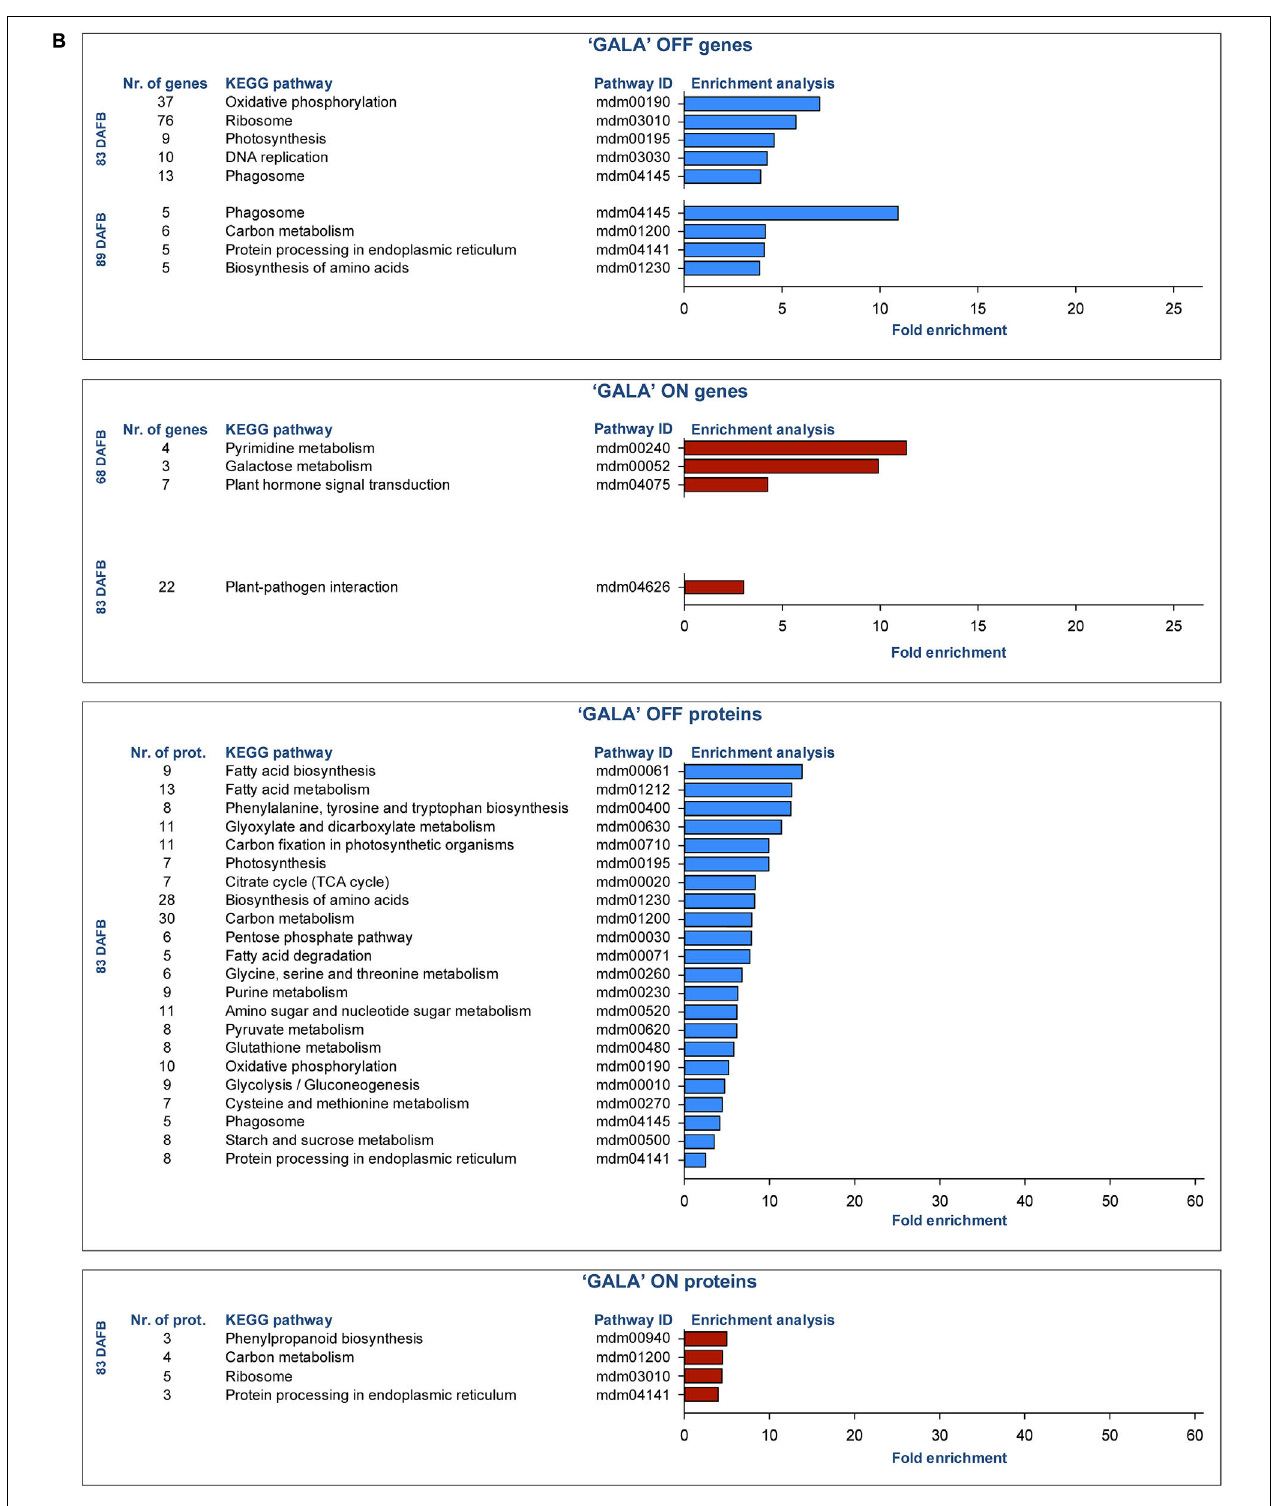
FIGURE 5 | Enrichment analysis of KEGG pathways of differently expressed genes (DEGs) and differentially abundant proteins (DAPs) between ON- and OFF-trees of ‘Fuji’ (A) and ‘Gala’ (B) . Fold enrichment was calculated by comparing the background frequency of total genes or proteins annotated to that term in Malus × domestica to the sample frequency, representing the number of genes or proteins entered that fall under the same term (Dalmer and Clugston, 2019). In ‘Fuji’ ON, no significantly enriched pathways of DAPs were found. Detailed information about pathway entries and statistics is provided in Supplementary Tables 1–3